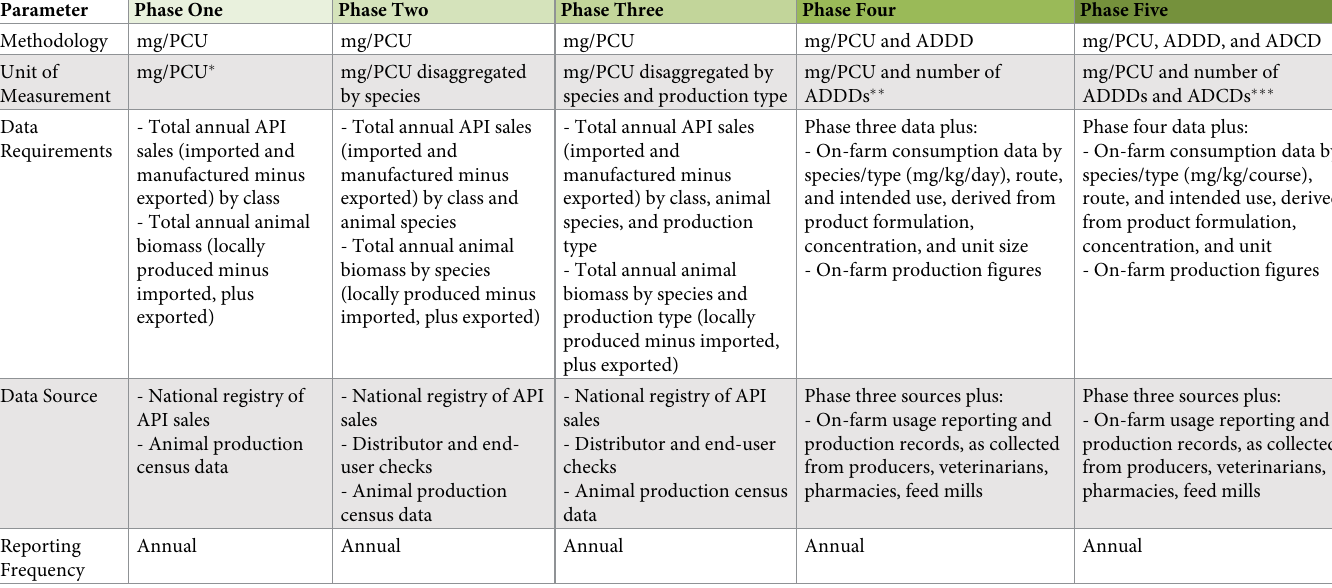
Table 1. Phased capacity approach to establishing surveillance for antimicrobial consumption in food animal production context of